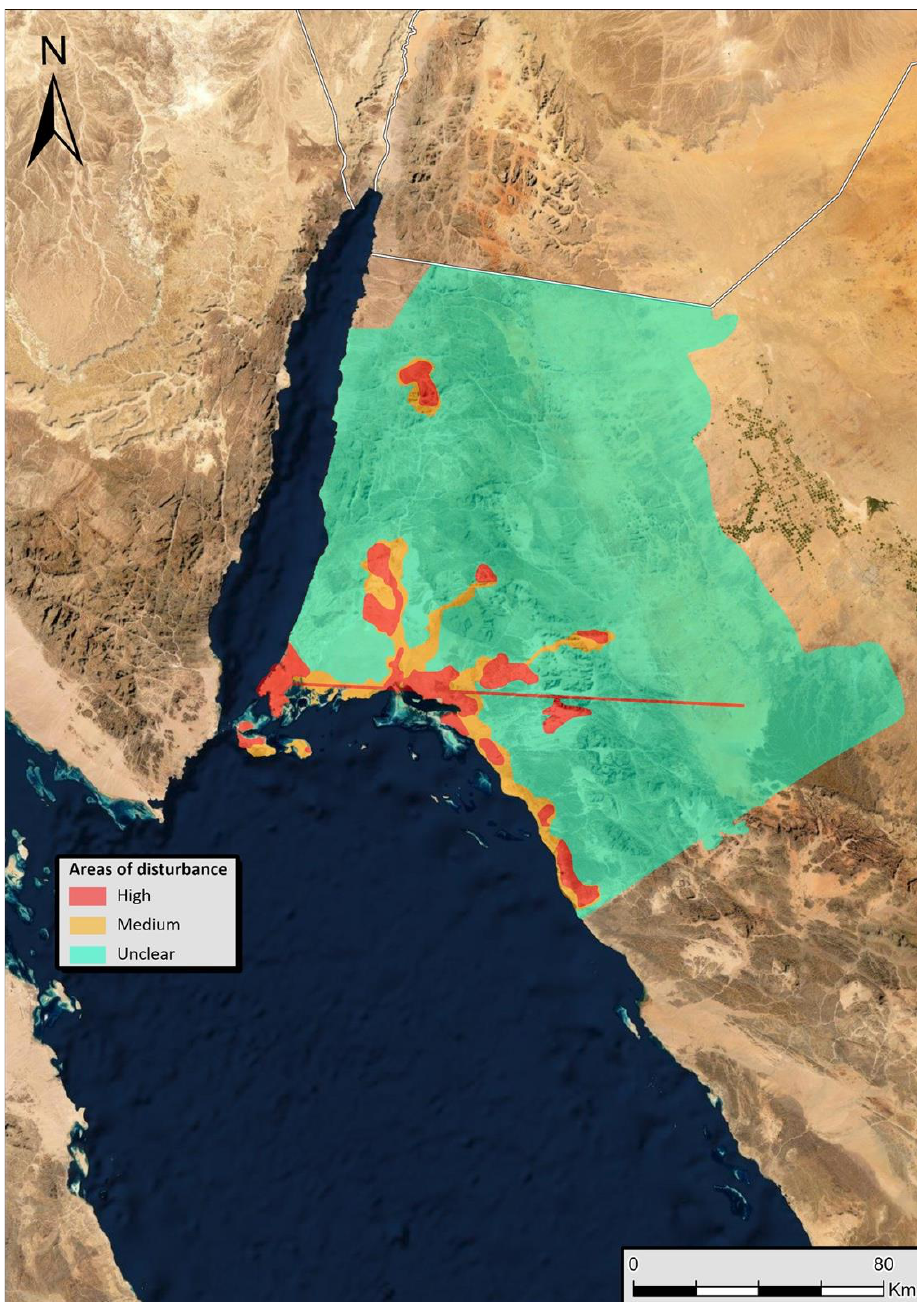
Figure 3. Highlighting the Neom impact areas based on published plans. The red line relates to the Figure 3. The geology of the survey area, adapted from Line development.